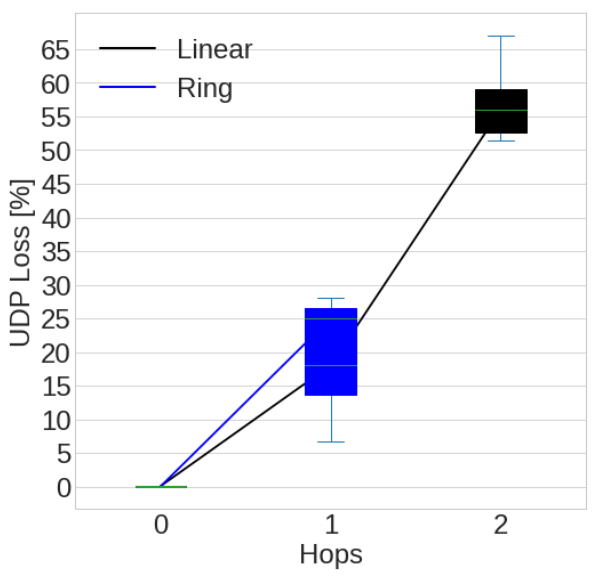
Figure 30. CityLab UDP